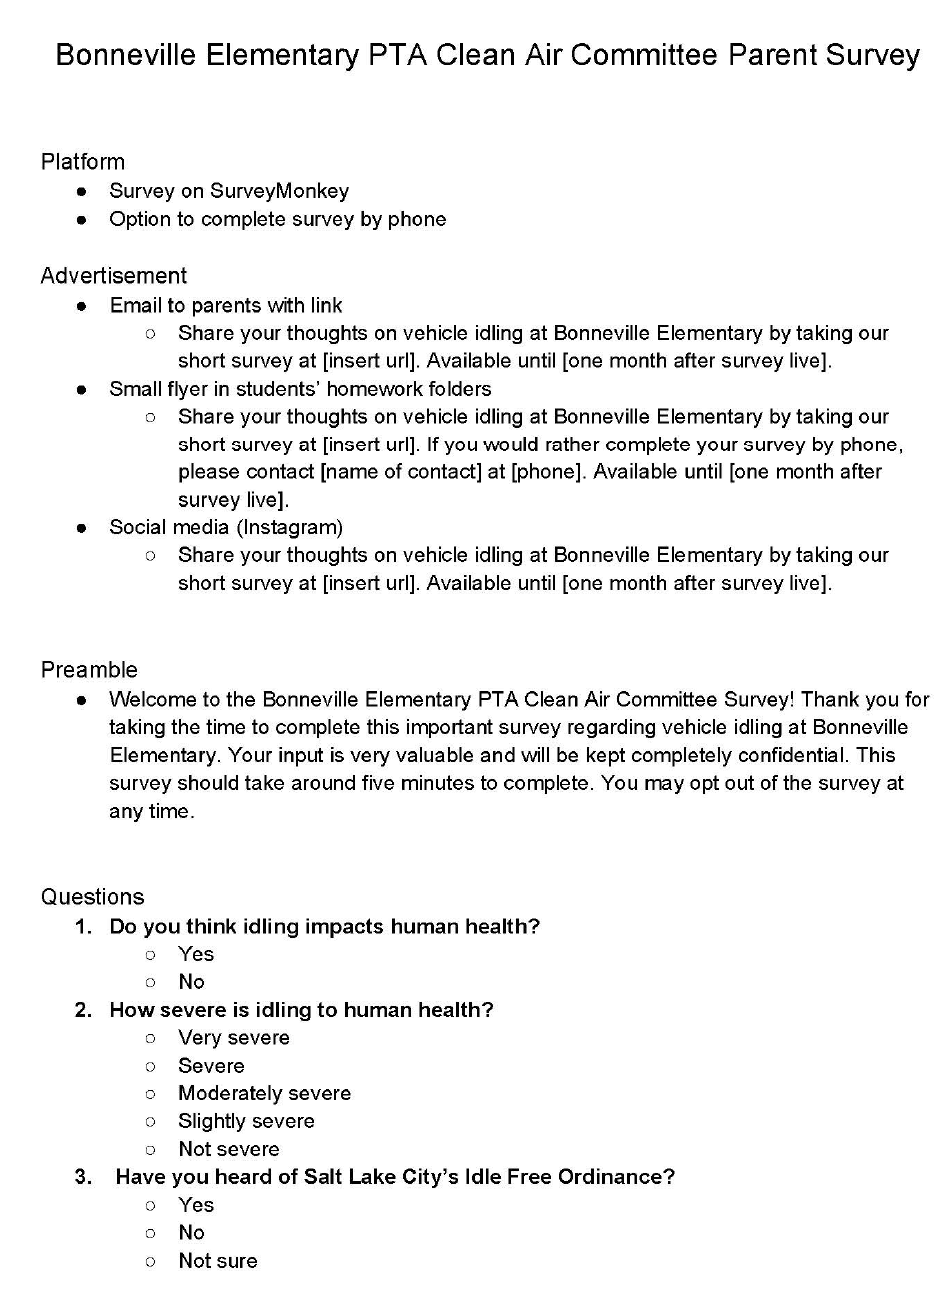
Figure A1. Clean air campaign community survey page 1 of 3.